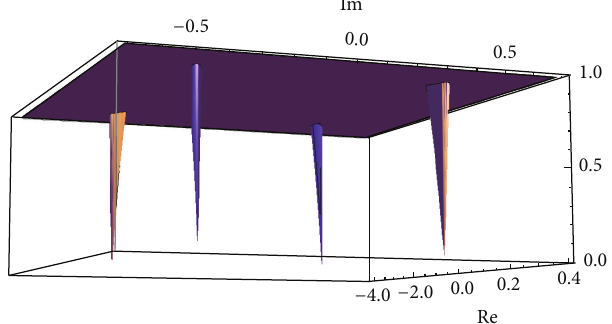
Figure 11: Stability function of attractive strange fixed points of